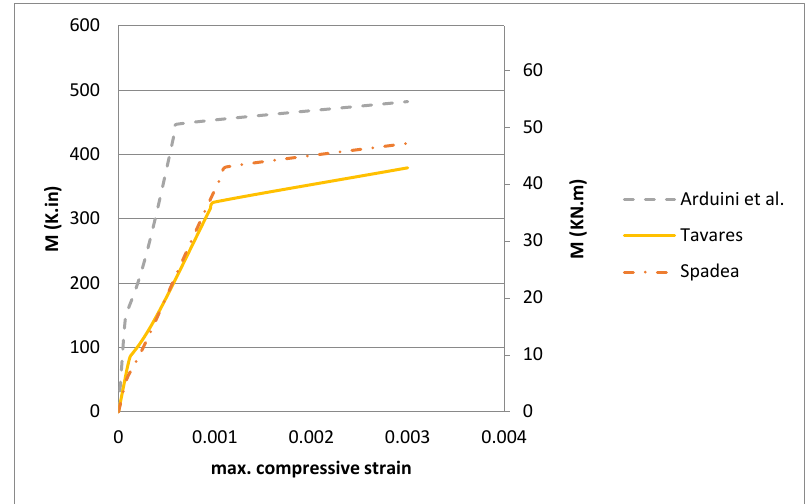
Figure 10. Arduini et al. (1997) [14], Tavares et al. (2008) [13] and Spadea et al. (1998) [15] moment vs. maximum compressive strain analytical graphs.